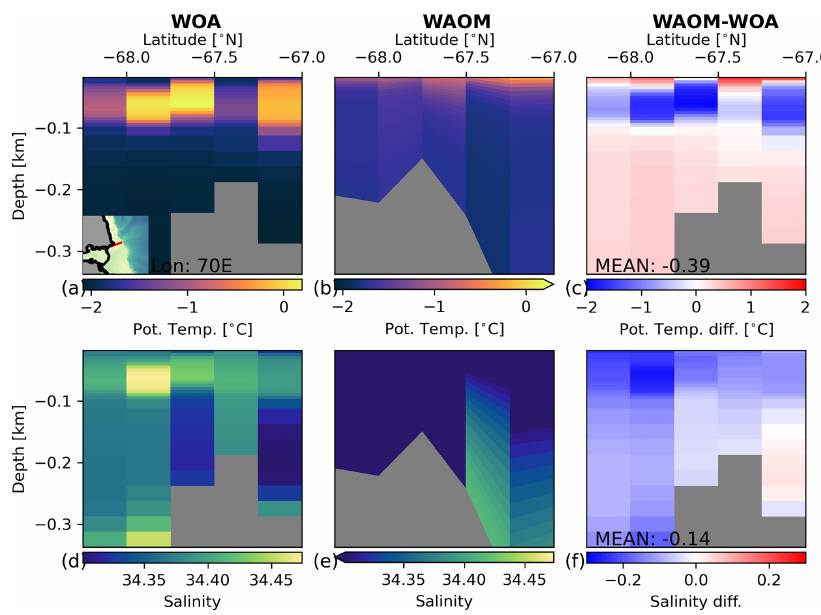
Figure 13. As Fig. 11, but for a transect in Prydz Bay (Davis Sea continental shelf) along 70 ◦ E.